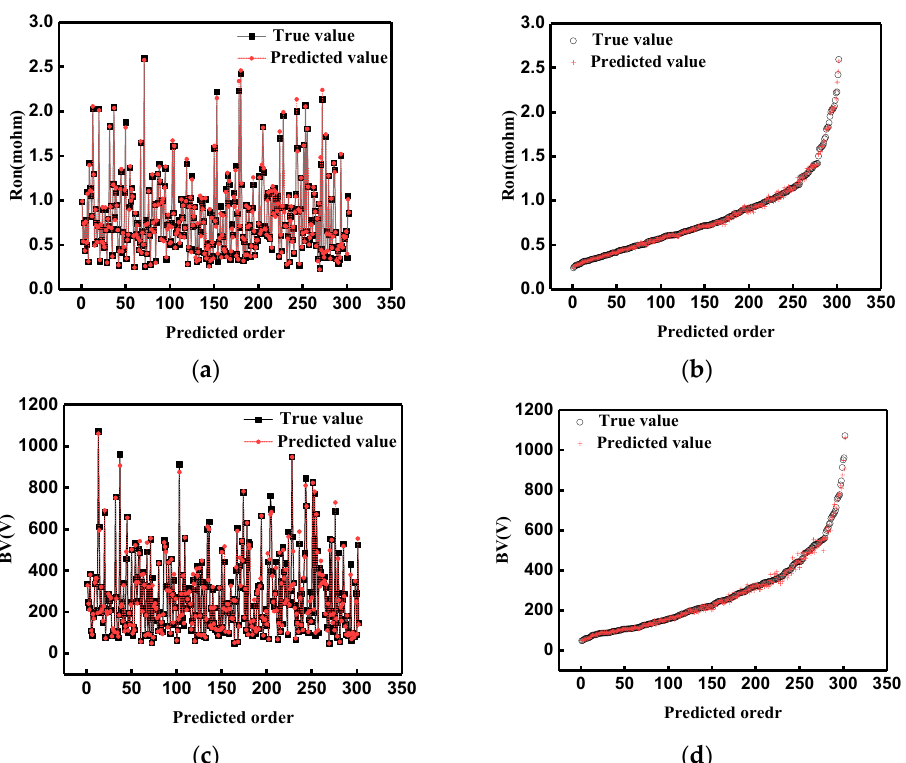
Figure 7. The prediction results of Ron and BV. ( a ) The disordered prediction results of Ron. ( b ) The prediction results of Ron under forward ranking. ( c ) The disordered prediction results of BV. ( d ) The prediction results of BV under forward order.